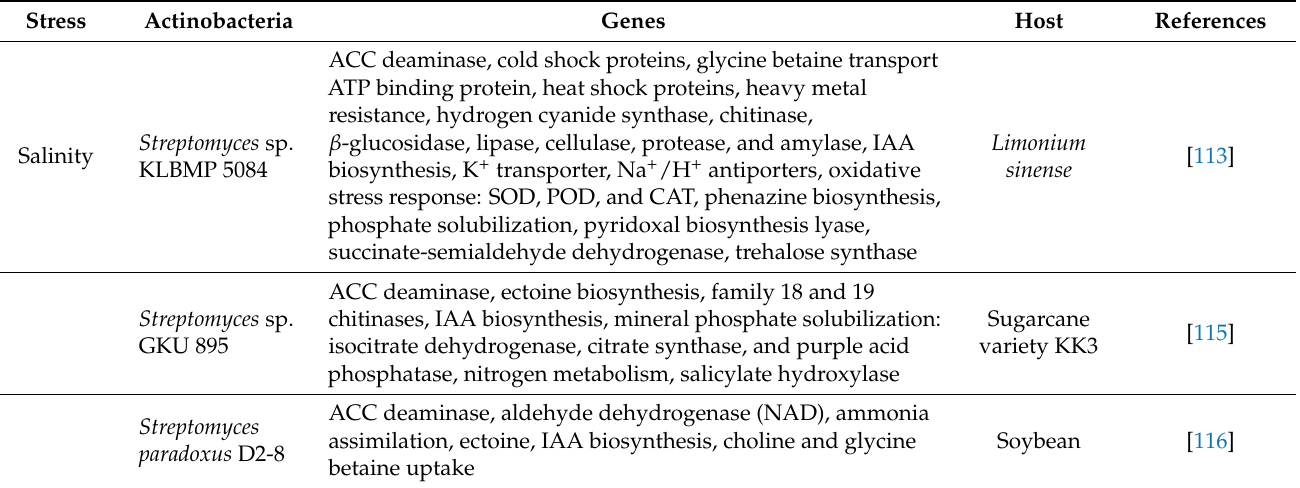
Table 1. Genomics approaches to understand actinobacterial-mediated genes alleviating abiotic stress in